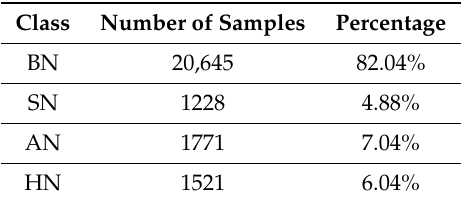
Table 1. Class distribution of the samples in the